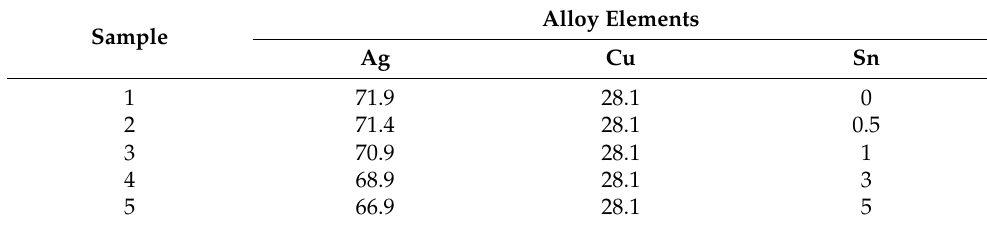
Table 1. Chemical compositions of the cast Ag-Cu alloys